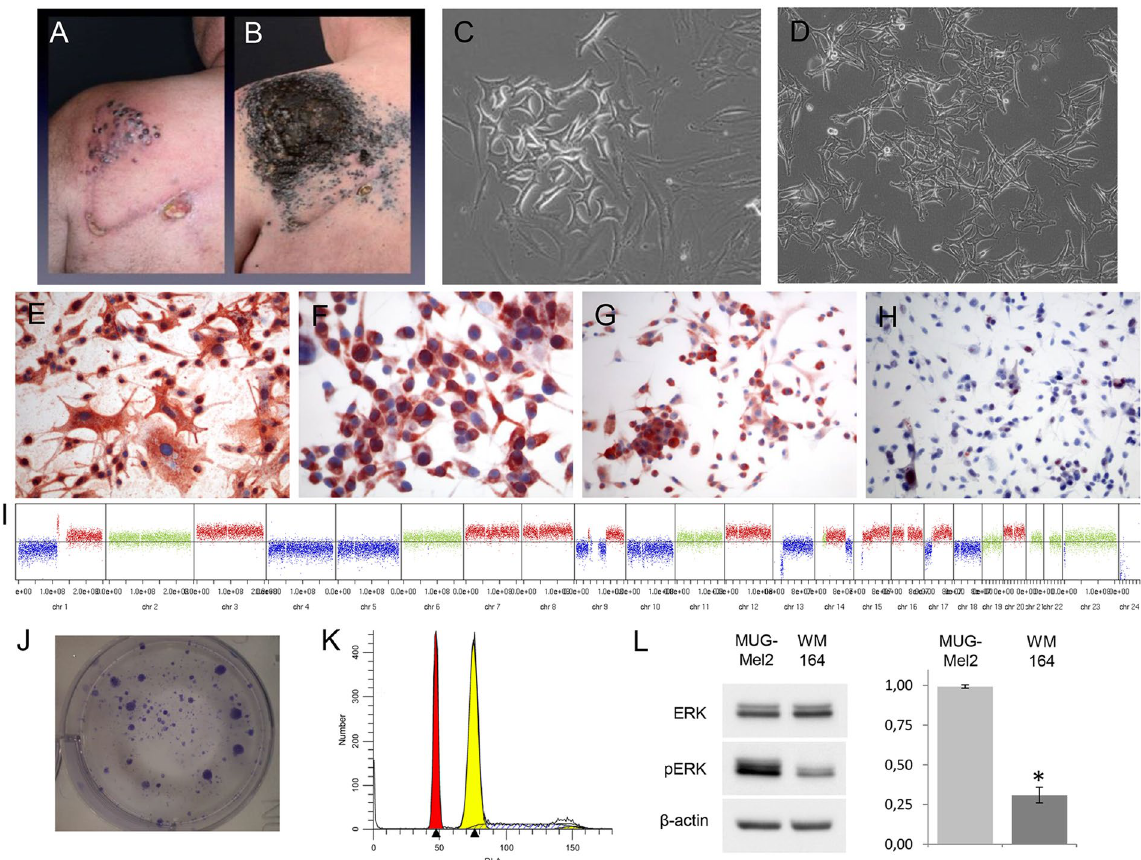
Figure 2. Male patient with cutaneous metastases appearing shortly after wide surgical excision of a primary melanoma on his left shoulder ( A ). Rapid progression of cutaneous metastases three months after the excision of the primary melanoma irrespective of targeted therapy ( B ), outgrowth of melanoma tumor cells surrounded by stroma cells ( C ), MUG-Mel2 cell line after ten days ( D ). Immunohistochemistry revealed in a strong HMB- 45 expression ( E ), strong Melan-A expression ( F ) strong Tyrosinase expression ( G ) and a weak S-100 expression ( H ). Copy number variation profile of MUG-Mel2 passage 89. Regions with log2 ratios > 0.2 that indicate gains of chromosomal material are shown in red and those with log2 ratios < − 0.2 that indicate loss of chromosomal material are shown in blue. Balanced genomic regions are depicted in green ( I ). Tumorigenicity was performed by CFU assay ( J ). DNA index was calculated by analyzing the geometric mean of MUG-Mel2 and MNC. DNA index of 1.6 was calculated, which means that the tumor cells were hyperdiploid, cell cycle was analysed by ModFit software 4.1, red peak indicats G1 peak of MNC, yellow peak G1 peak of MUG-Mel2 cells ( K ). Phosphorylation of ERK was determined by Western blot, WM164 was used as control cell line ( L